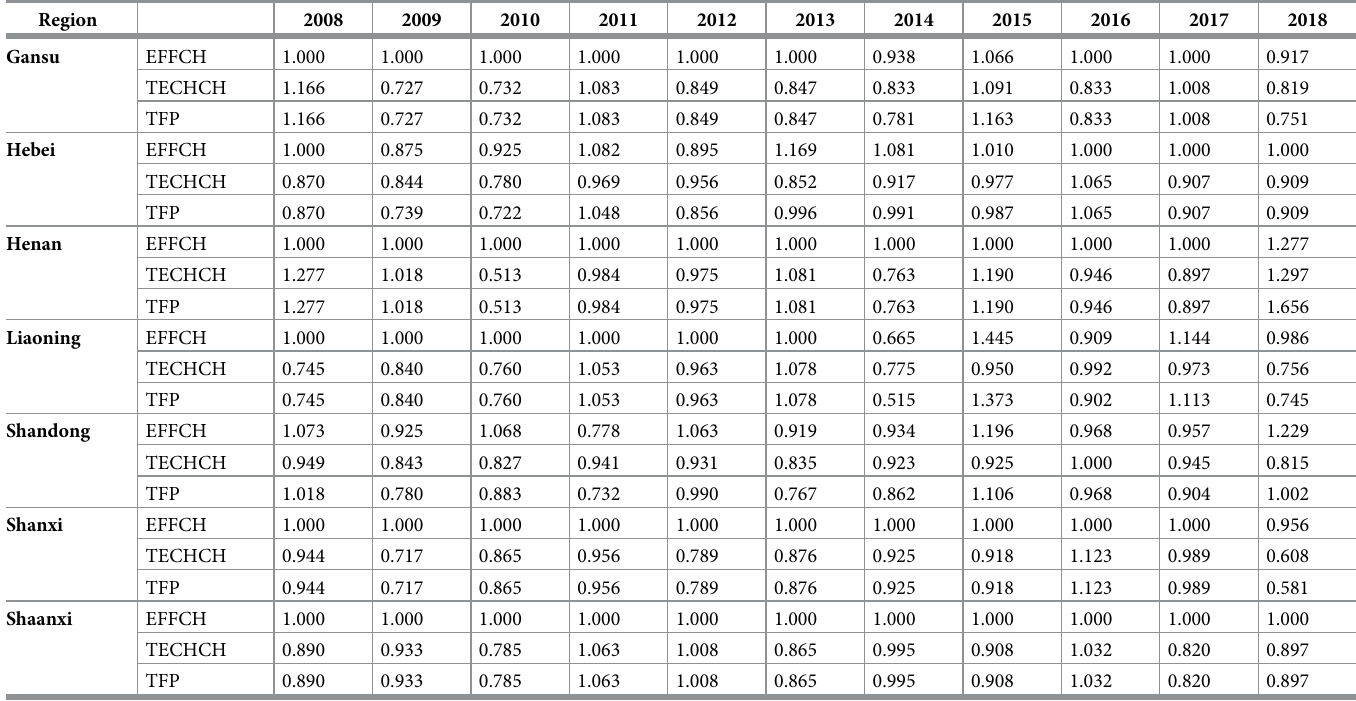
Table 3. Time-series changes of apple total factor productivity and its contribution from 2008–2018.